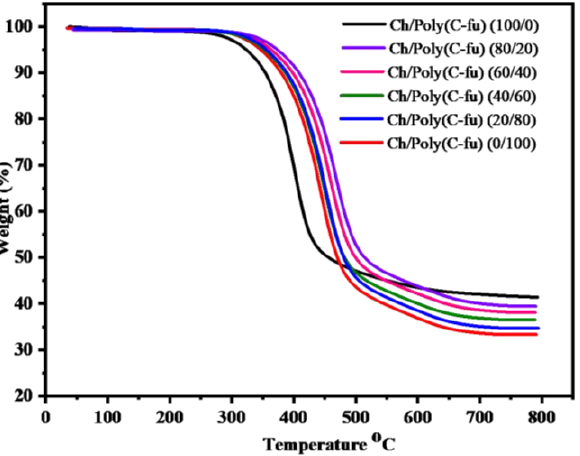
Figure 5. TGA thermograms of poly (Ch/C-fu)